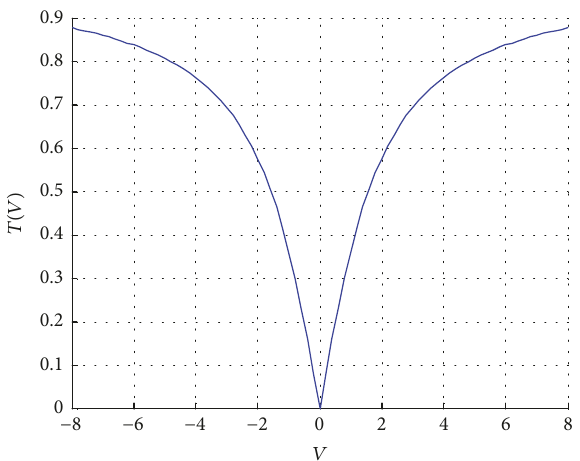
Figure 2: V -type transfer